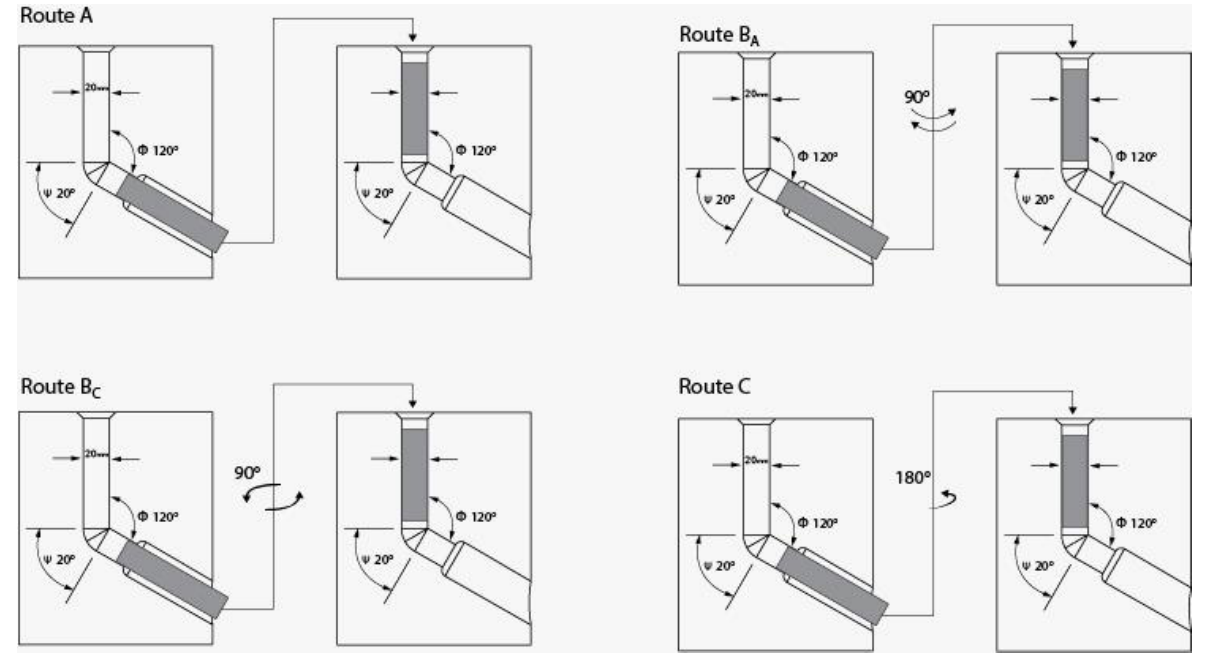
Figure 2. Schematic of four routes of multi-pass ECAP [14].